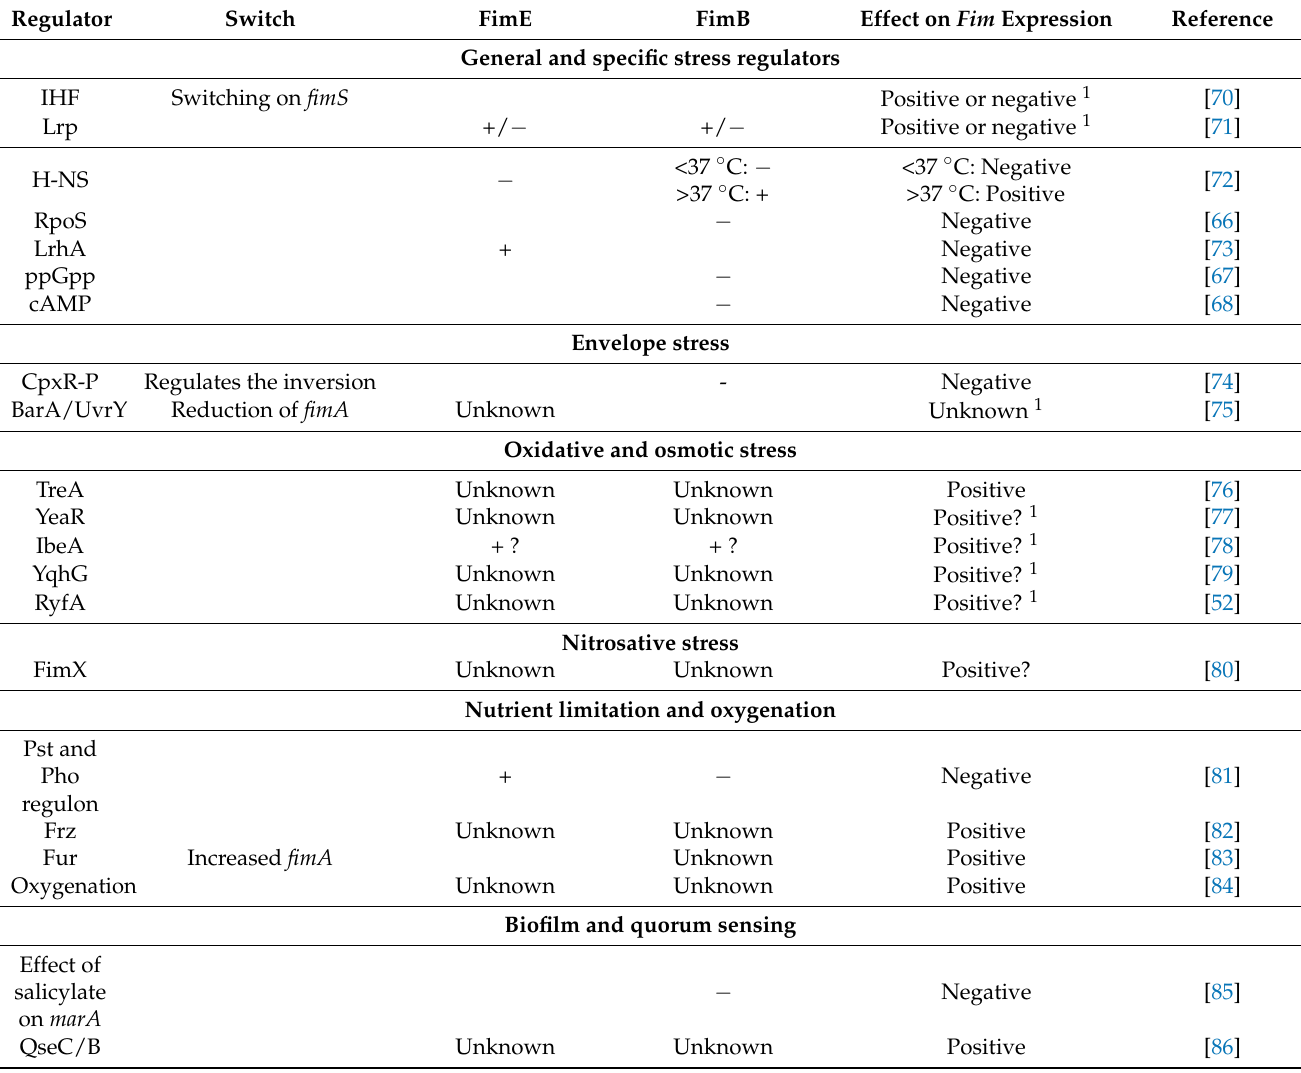
Table 2. Example of regulators of type 1 fimbriae in ExPEC involved in stress